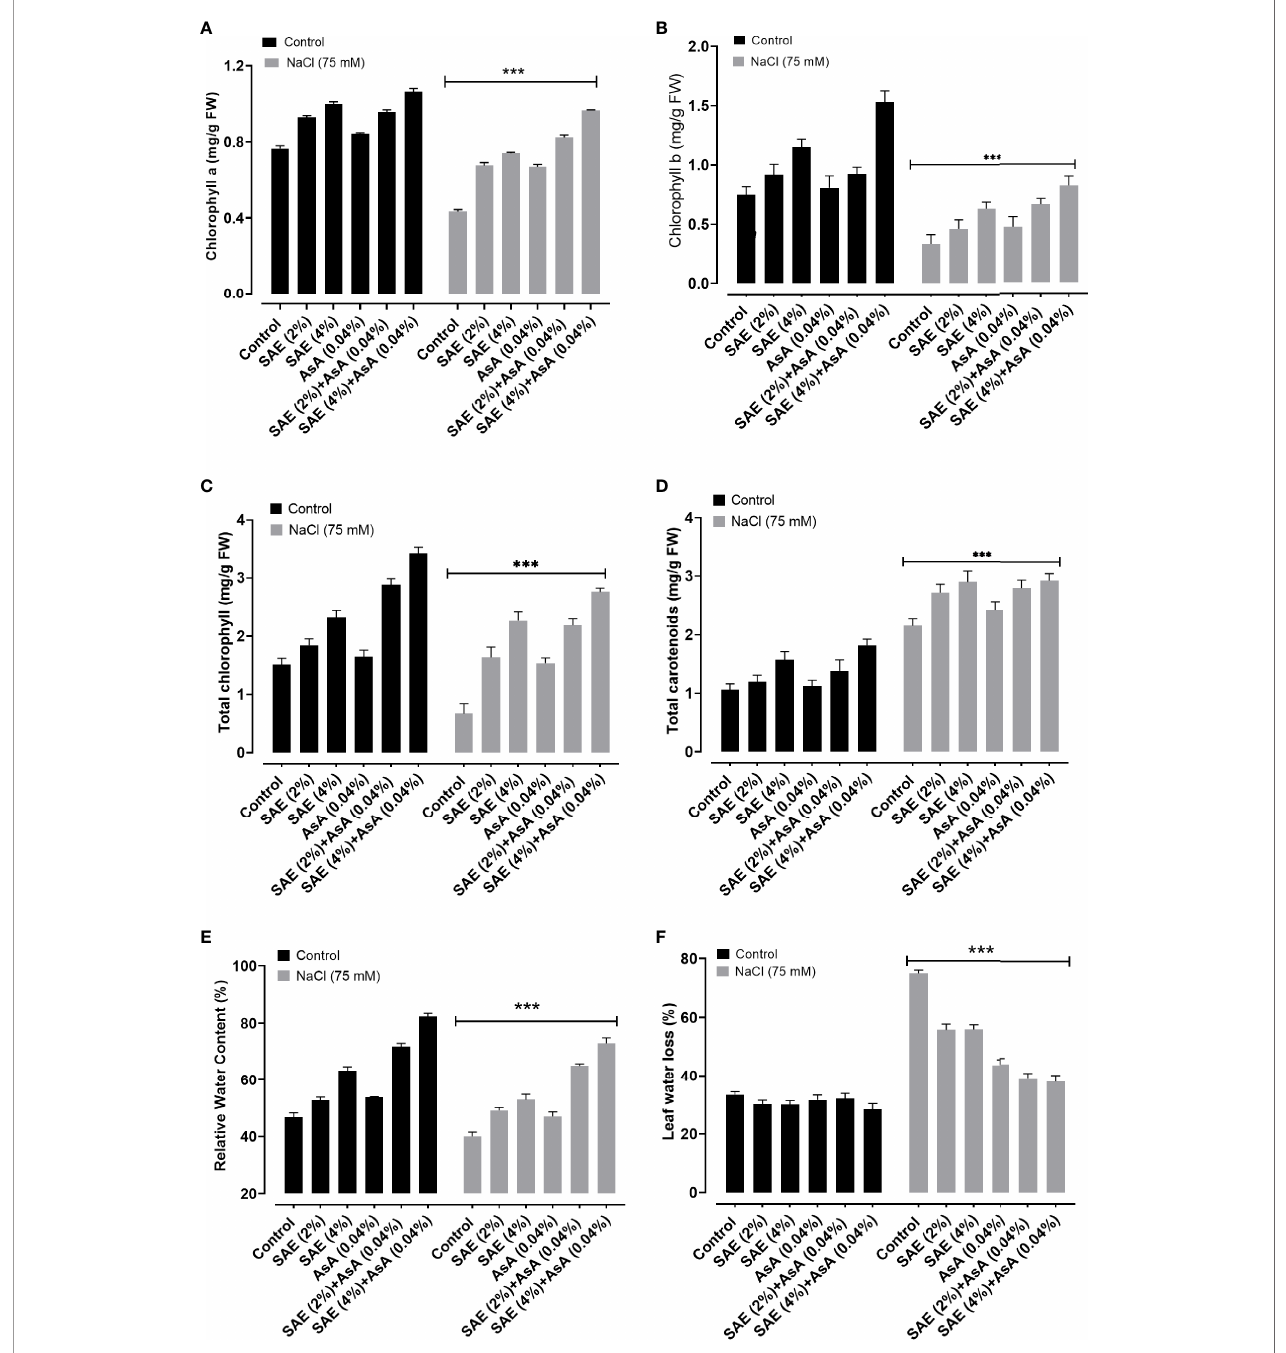
FIGURE 4 | Effect of SAE on pigment composition and water content of Abelmoschus esculentus grown under salt stress. (A) Chlorophyll a; (B) chlorophyll b; (C) total chlorophyll; (D) carotenoids; (E) relative water content; (F) leaf water loss. Error bars of quantitative data represent ± SEM (*** p < 0.005). LWL, leaf water loss; FW, fresh